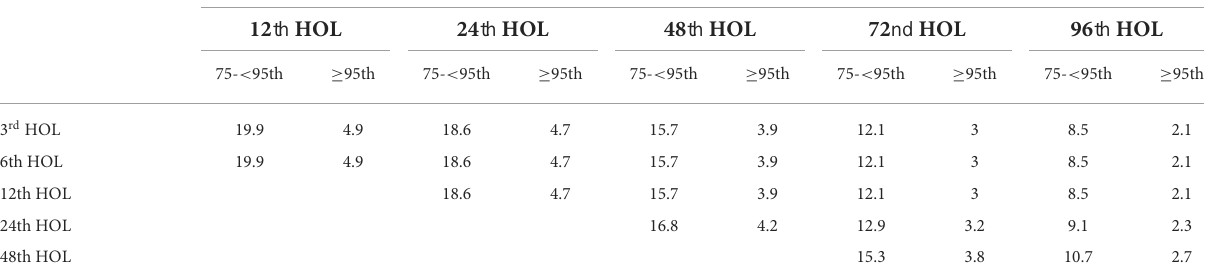
TABLE 3 25–50th percentile bilirubin levels and subsequent shift to higher percentile groups (75–<95th and ≥ 95th) at different time points. 25-50 th percentile